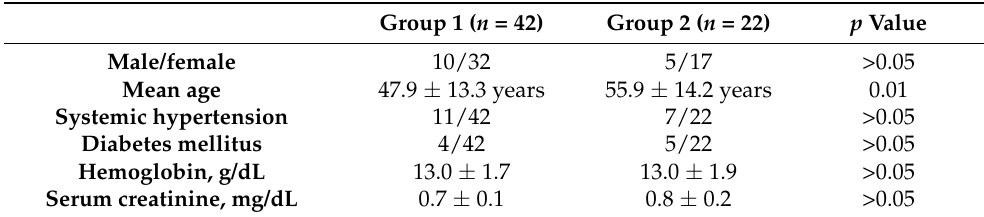
Table 1. Clinical characteristics in groups 1 (presence of pretest information) and 2 (absence of pretest